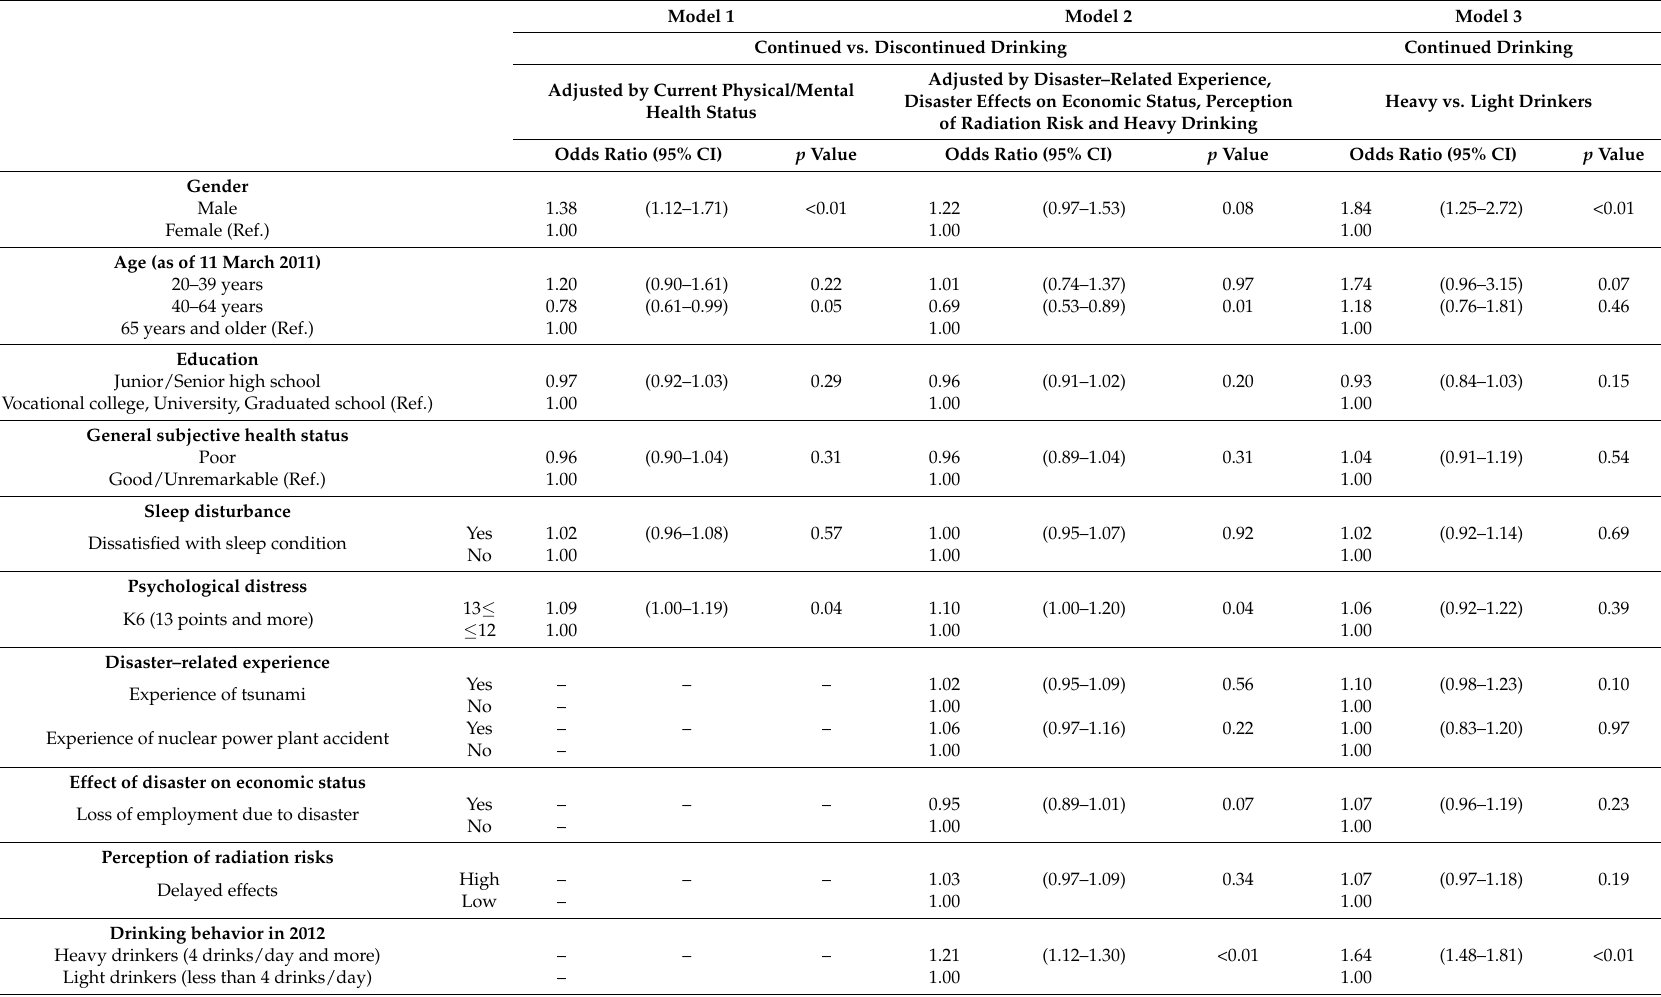
Table 5. Multivariate logistic regression analysis of continued drinking